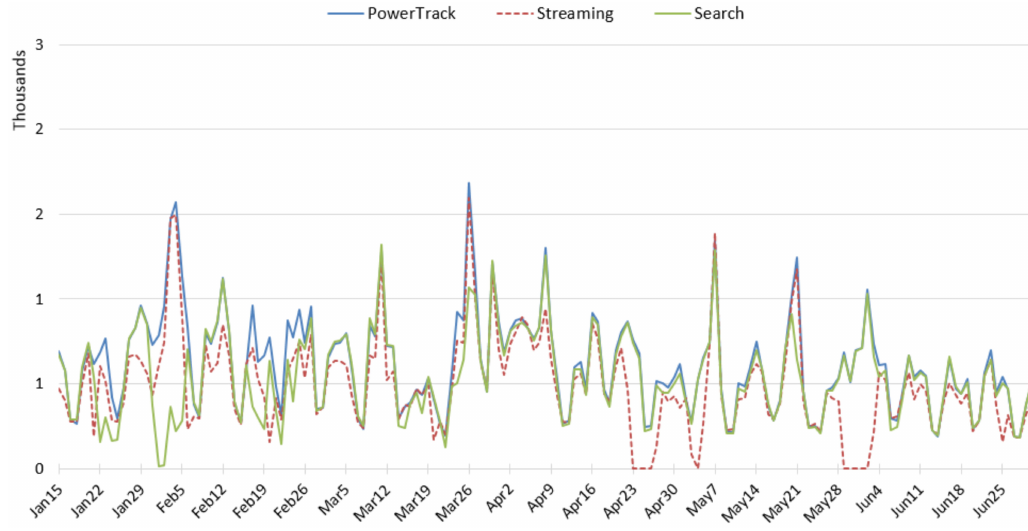
Figure 6. Daily amount of anti-smoking-related tweets across